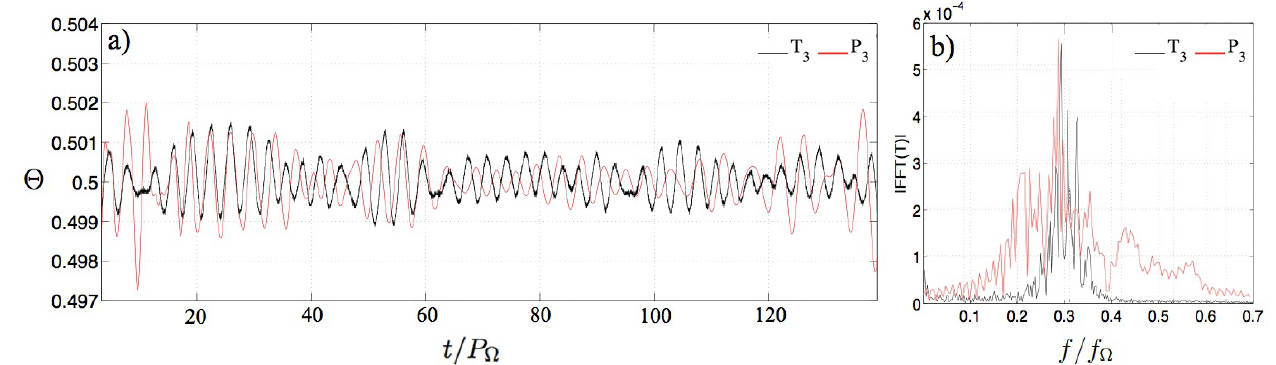
Figure 16. ( a ) Temperature time series acquired on thermistors T experiment (with temperature normalized by ∆ T ) and the corresponding time series of the non-dimensional temperatures measured on the point probe P ( b ) corresponding Fourier